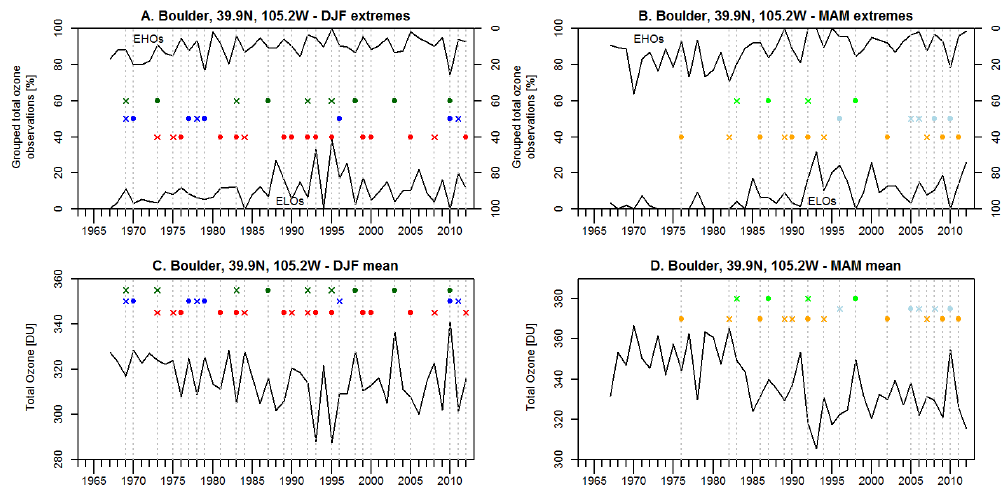
Figure 3. “Fingerprints” of the NAO and ENSO as detected for Boulder in the seasonal frequency time series of EHOs (right axis, top to bottom) and ELOs (left axis, bottom to top) for (a) winter (DJF) and (b) spring (MAM). Panels (c) and (d) show fingerprints in seasonal mean column ozone. Filled circles denote visible fingerprints and crosses denote not visible fingerprints. NAO positive (negative) phase is indicated for winter in red (blue) and for spring in orange (light blue); ENSO positive phase is indicated for winter (spring) in green (light green).